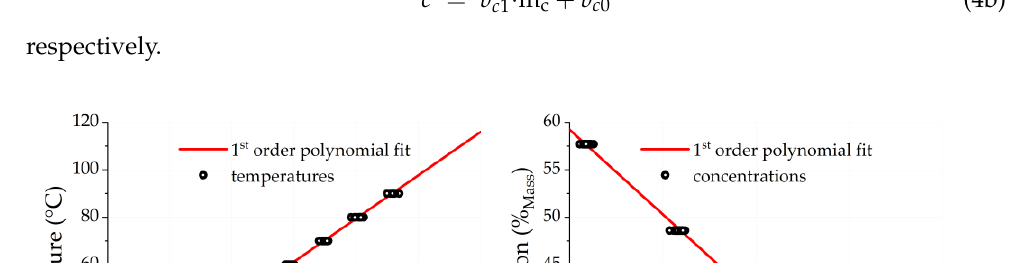
Figure 9. Schematic of calibration procedure (blue box) and subsequent measurement data evalua- tion (green box) for temperature evaluation. Concentration evaluation is performed in the same manner.